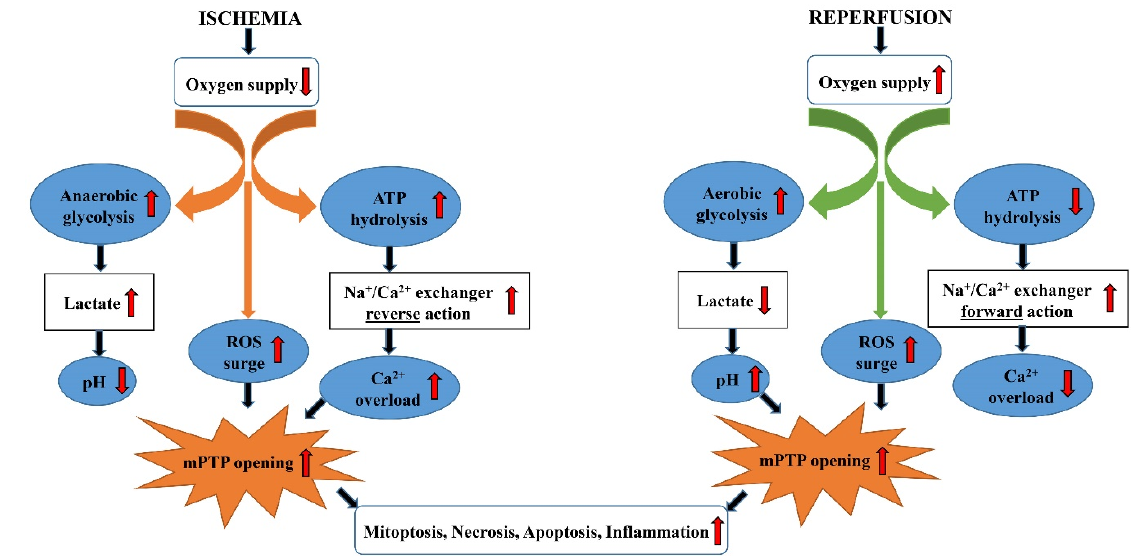
Figure 1. The chain of metabolic events that accompany I/R injury. Na + /Ca 2+ —Na + /Ca 2+ electrogenic exchanger (NCX); ROS—reactive oxygen species; mPTP—mitochondrial inner membranes permeability transition pores.